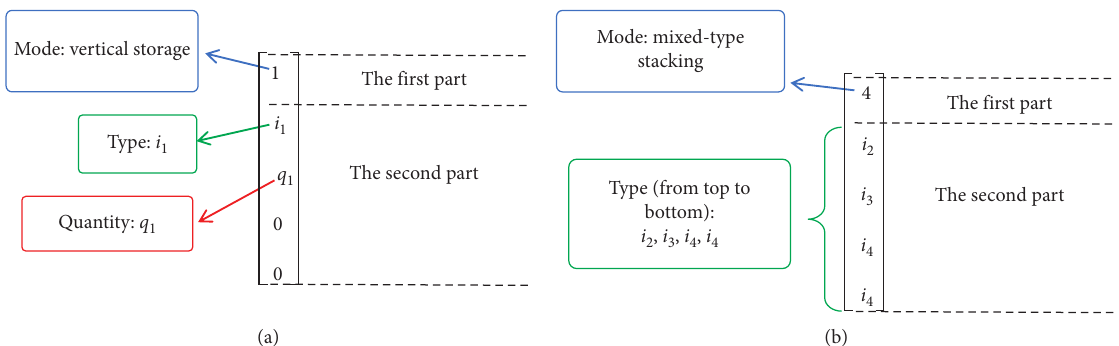
Figure 4: Vectors used to describe the bay storage state of different storage modes: (a) vertical, tiled, and same-type stacking; (b) mixed-type stacking.